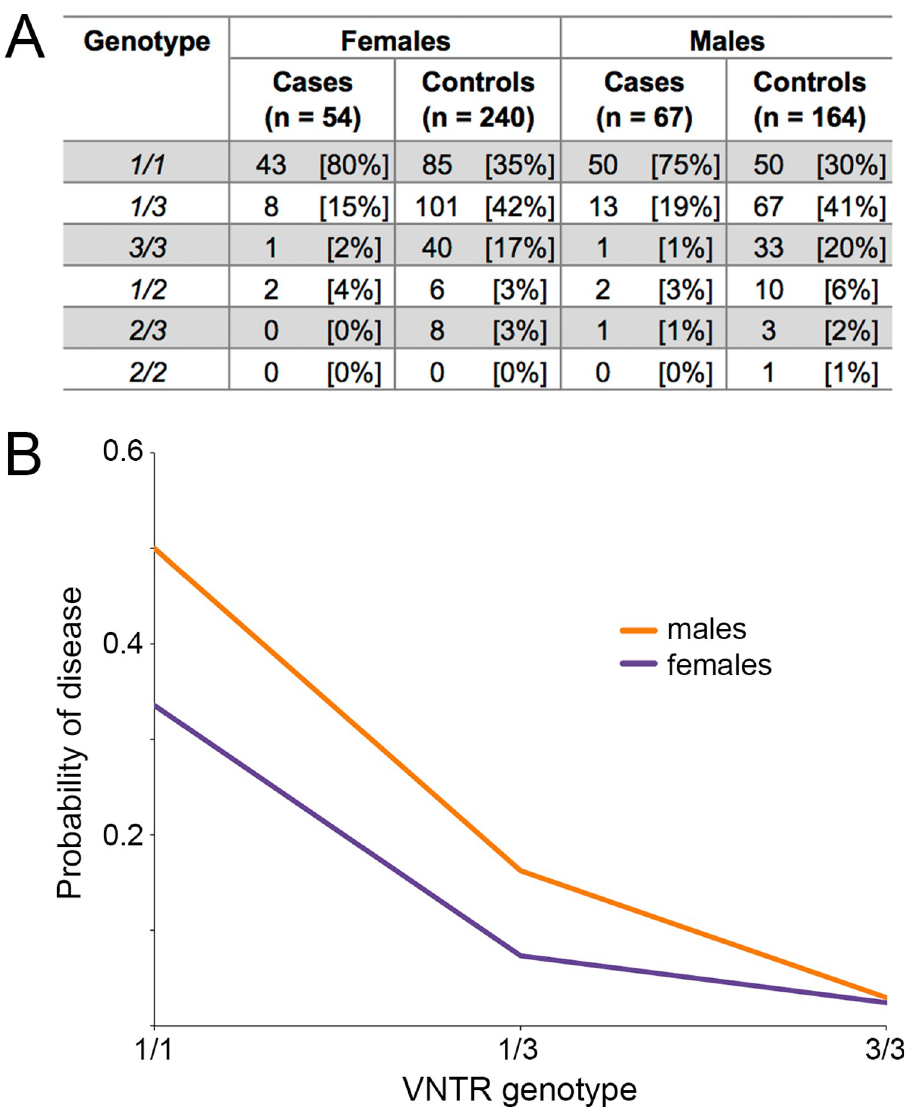
Fig 6. Observed VNTR genotypes and disease probabilities in GSDs. A) Observed numbers of cases and controls having each genotype are reported by sex in order of genotypic frequency. B) Probability of disease (y-axis) for the three most common genotypes (x-axis) are plotted for females and males. Probability of disease is significantly different between the sexes for the 1 / 1 (n = 228, P -val = 0.009) and 1 / 3 (n = 189, P -val = 0.046)